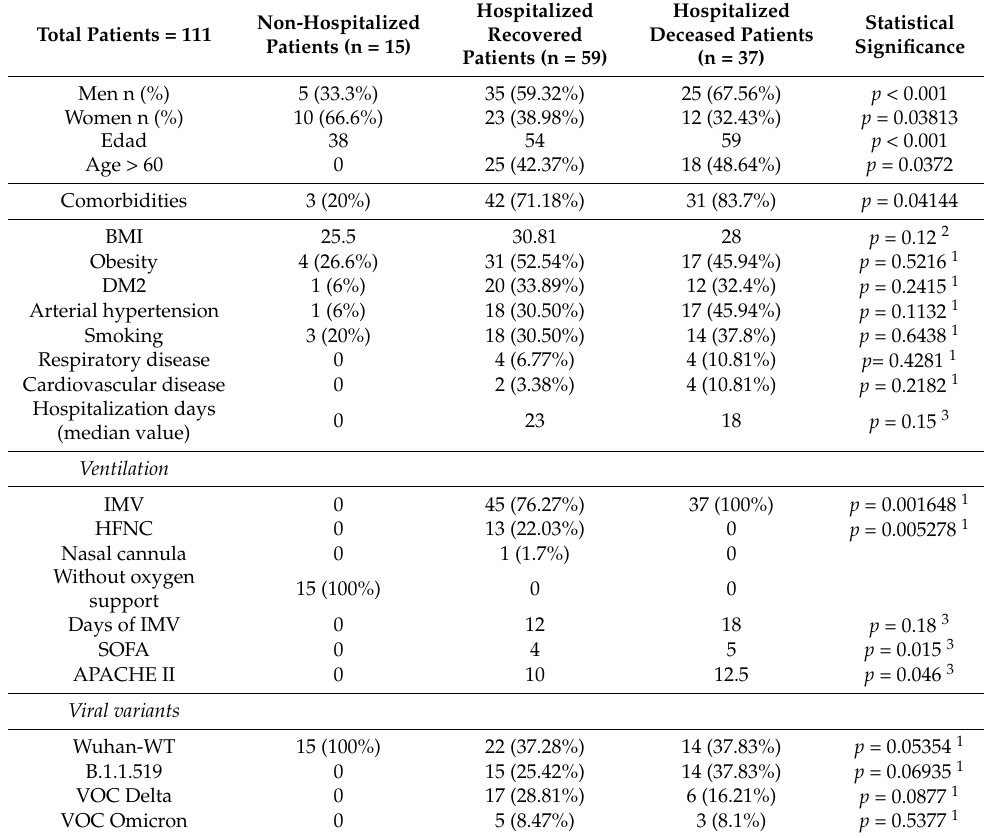
Table 1. Demographics of the